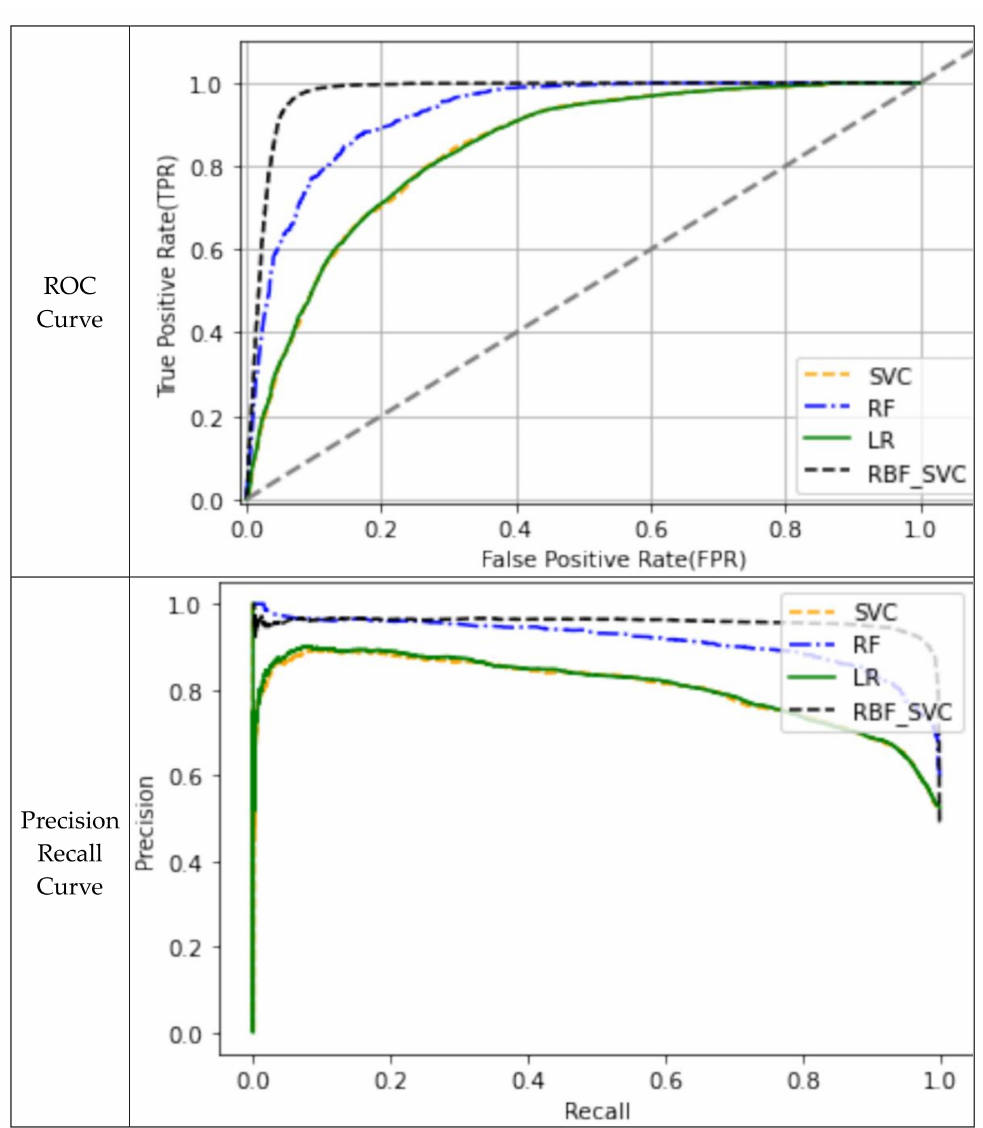
Figure 5. Evaluation